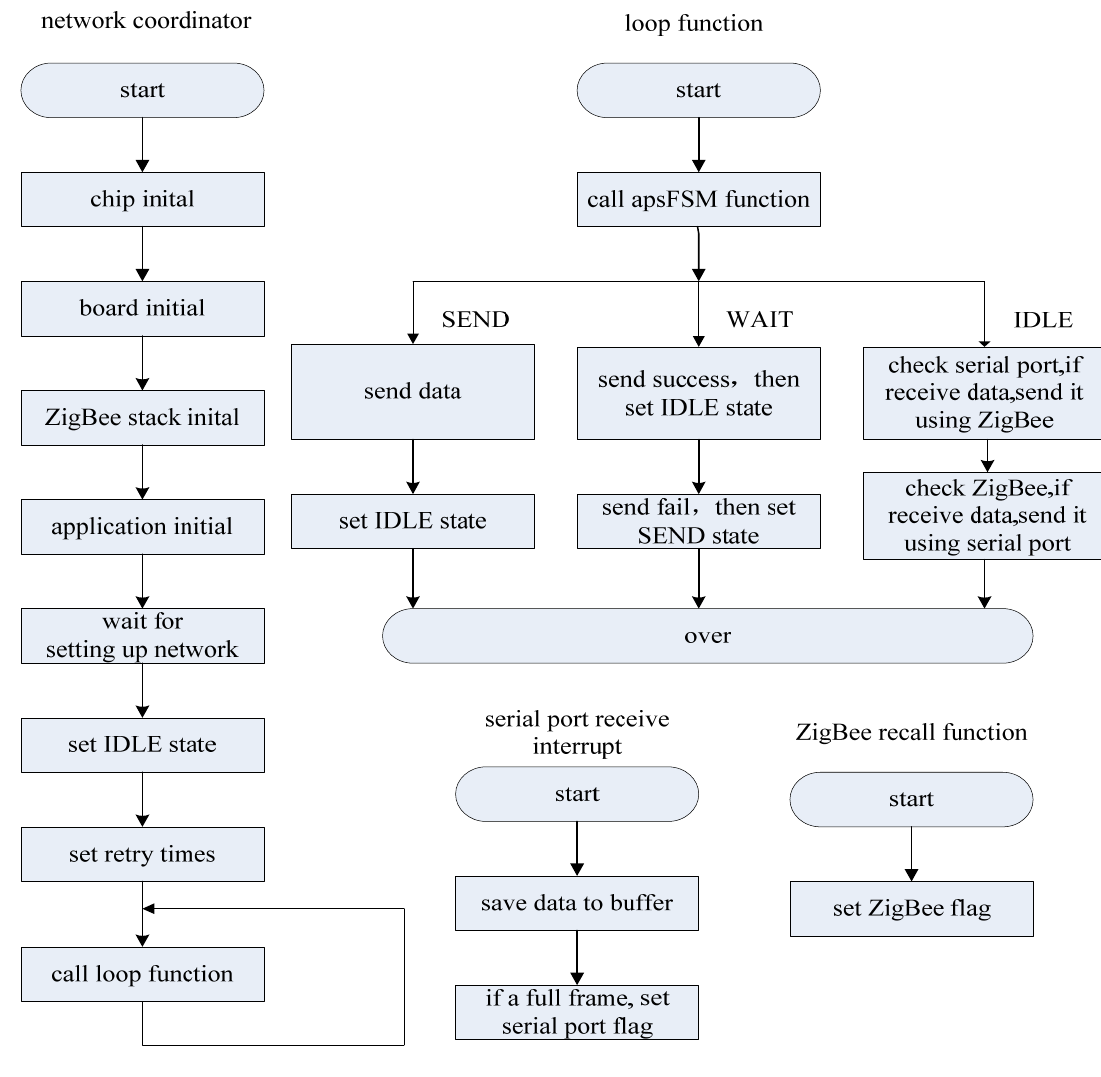
Figure 15. Application level process flow